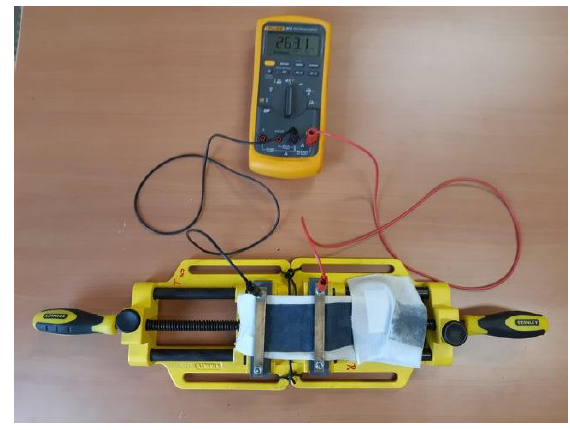
Figure 5. Two-point method resistance measurements set-up.